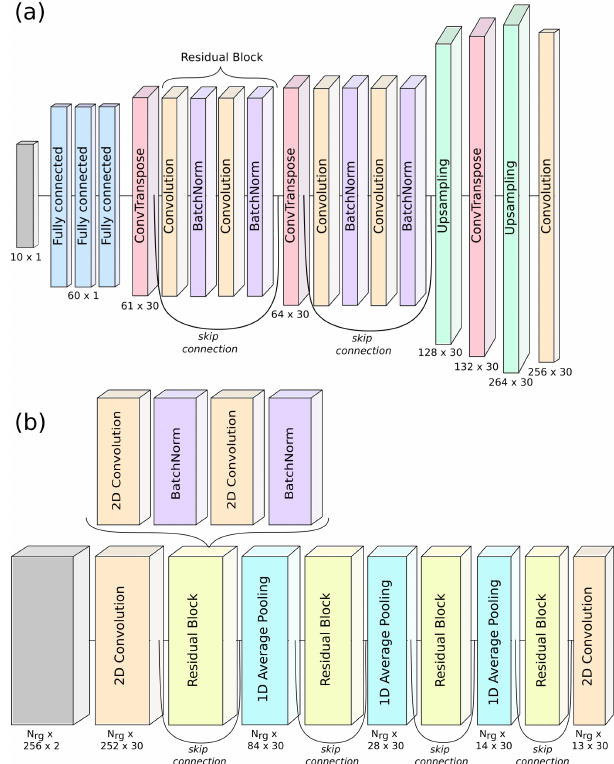
Figure 2. Architecture of the decoder (a) and encoder (b) neural networks. For the decoder, the architecture for the W band is shown; that of the X band is extremely similar, with only slightly different kernel widths. Skip connections indicate that the output of a given layer is kept and added to the output of a residual block. Color cod- ing indicates the type of each layer. The size of each layer is indi- cated; when not stated, the layer is the same size as the previous one. Note that for display reasons the velocity dimension is along the vertical in panel (a) and along the horizontal direction in panel (b)